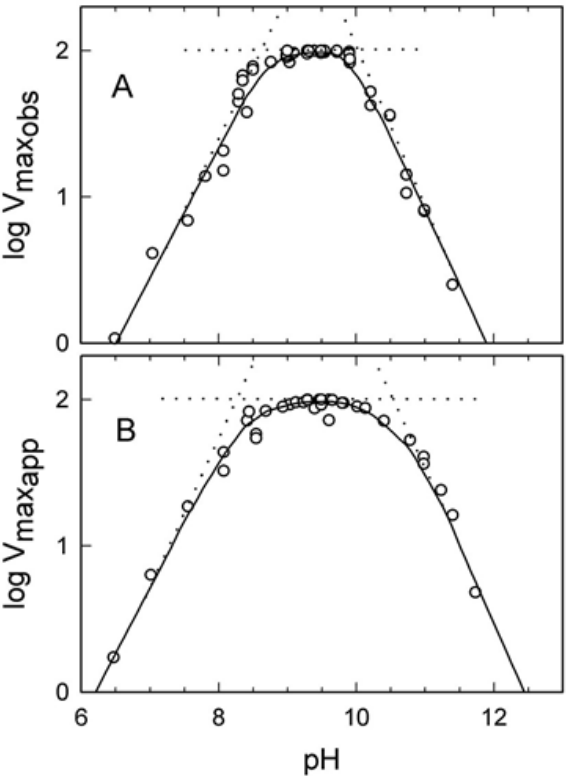
Figure 2: The pH dependence of the catalytic activity for the forward reaction: glutamate + 3-phosphohydroxypyruvate -> 2-oxoglutarate + phosphoserine for PSAT-BALC (A) and of PSAT-BCIRA (B). The experimental data are fitted to theoretical curves as described in the text. The pH optima 9.4 and 9.5 for PSAT-BALC and PSAT-BCIRA were obtained,